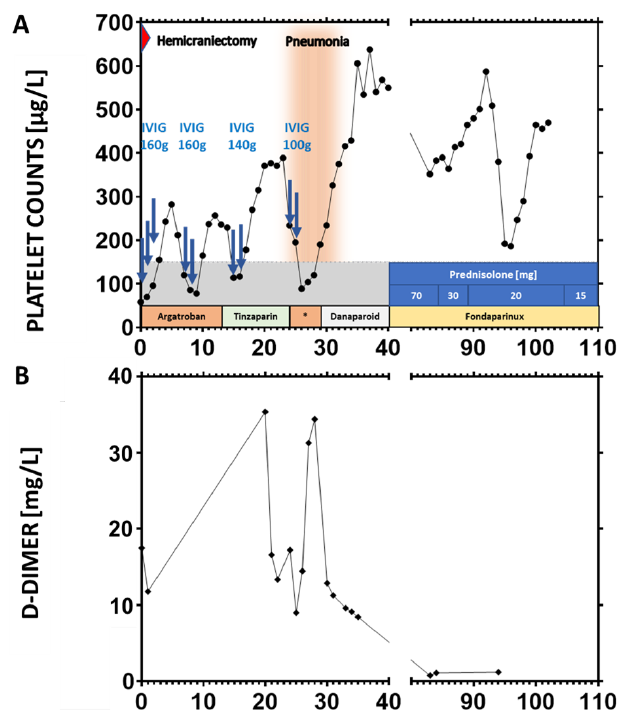
Figure 1. Course of Platelet Counts, anticoagulation treatment, and D-Dimers. Recurrent thrombocytopenia ( A ) and D-Dimer elevations ( B ) in perspective to disease onset (in days) on the x-axis. The grey area indicates the platelet range for thrombocytopenia. Intravenous immune globuline (IVIG) doses refer to the total doses (~2 g/kg body weight) administered at two or three consecutive days (each arrow indicates an administration). Dosages of anticoagulants were as follows: